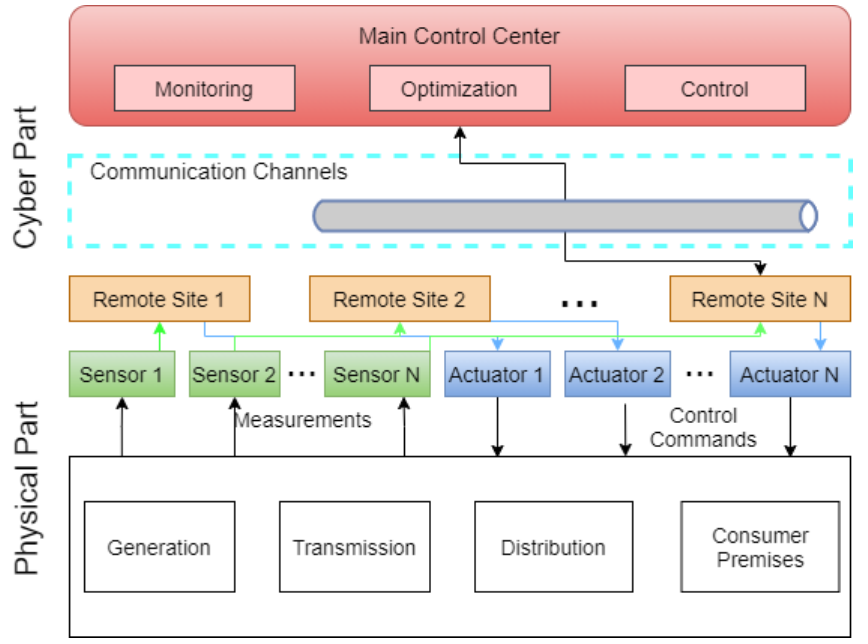
Figure 3. Typical Power SCADA